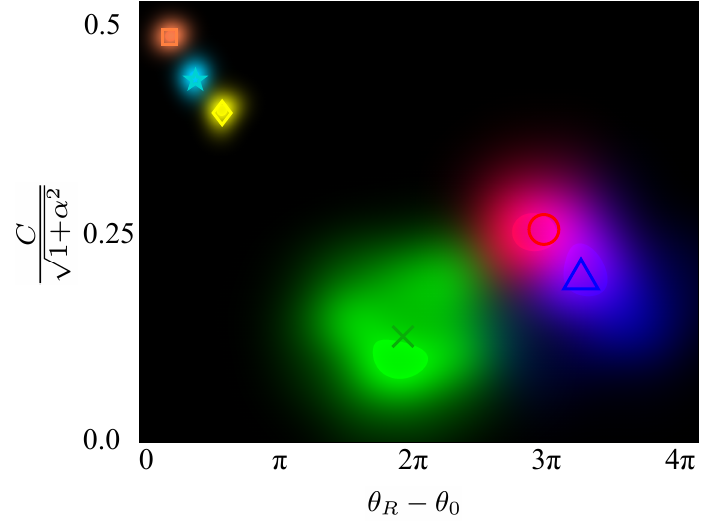
Figure 4. The distribution of the point cloud together with the centroid for the three plastics explosives: METABEL, SEMTEX, SX2 (indicated by red, green, blue clouds and circle, cross, triangle markers, respectively). Also shown for comparison are the point clouds for three homogenous plastics HDPE, PC, HDPE Black (indicated by orange, cyan, yellow clouds and square, star, diamond markers, respectively).